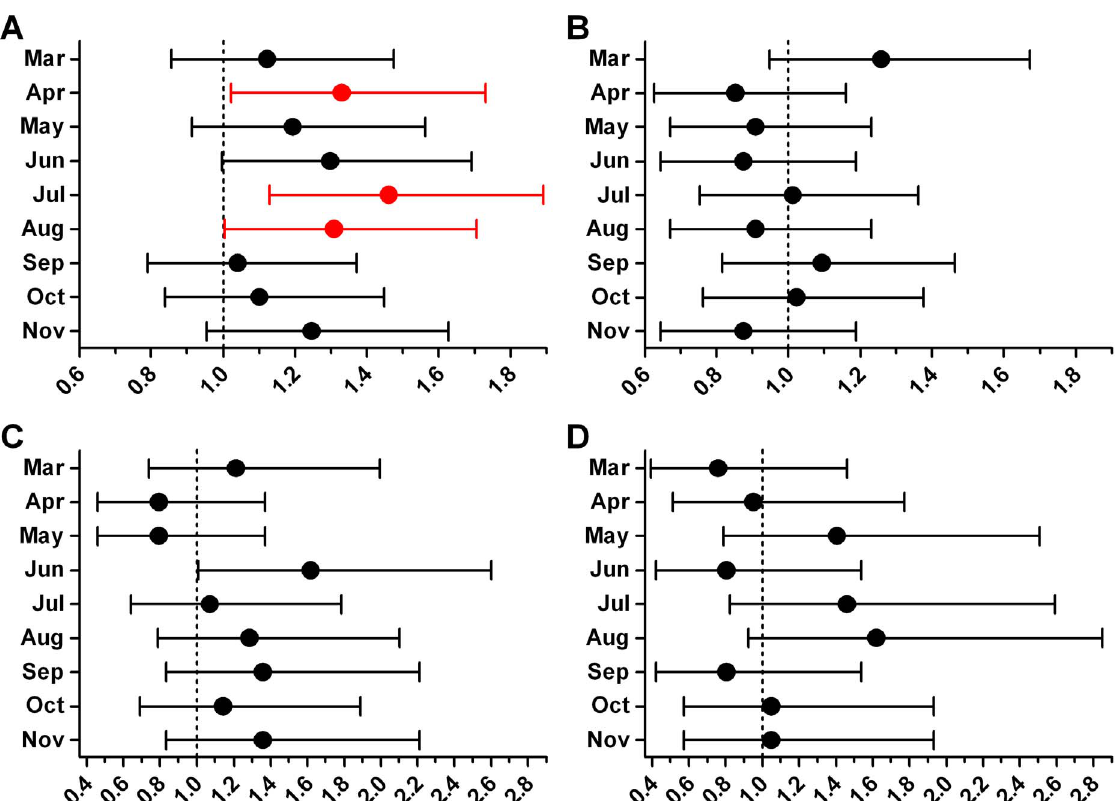
Figure 2. Odds ratio for each month versus winter. Data are shown with 95% confidence intervals and red denotes a statistically significant difference ( P , 0.05) versus winter (defined as the average number of cases in December, January, and February). (A) Detroit VTE. (B) Detroit no-VTE. (C) Suburban VTE. (D) Suburban no-VTE.